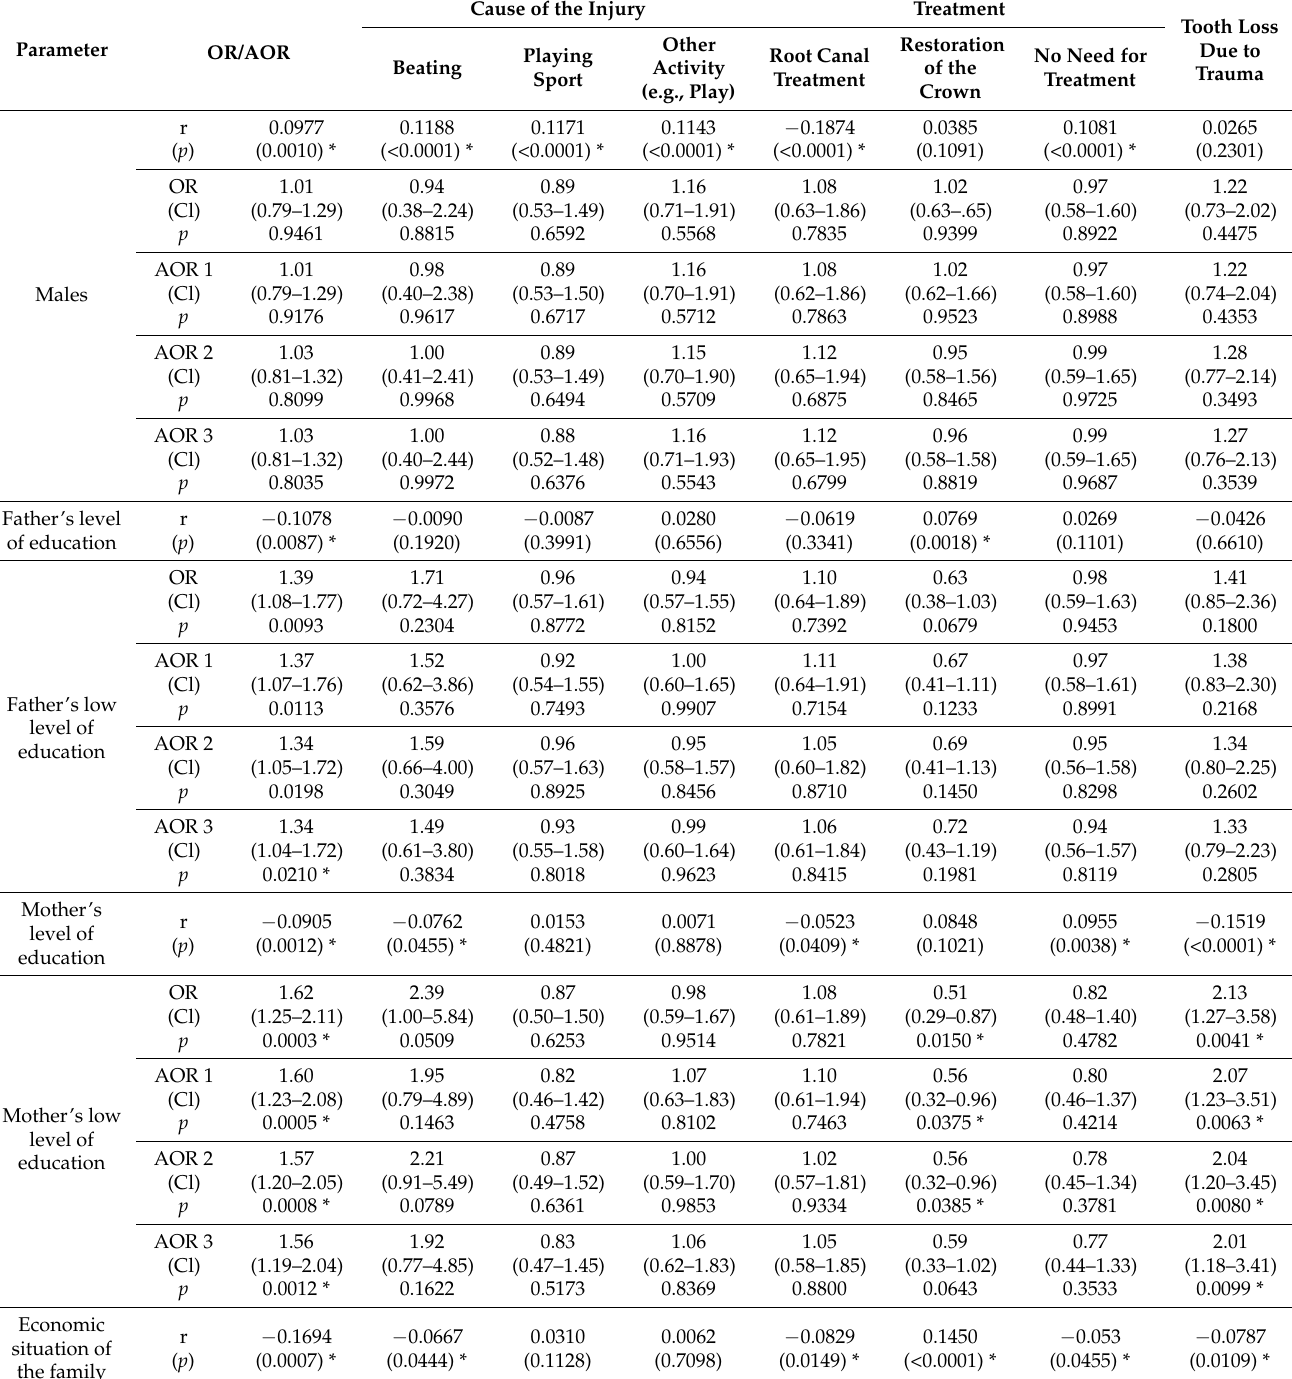
Table 5. Results of simple and multiple logistic regression